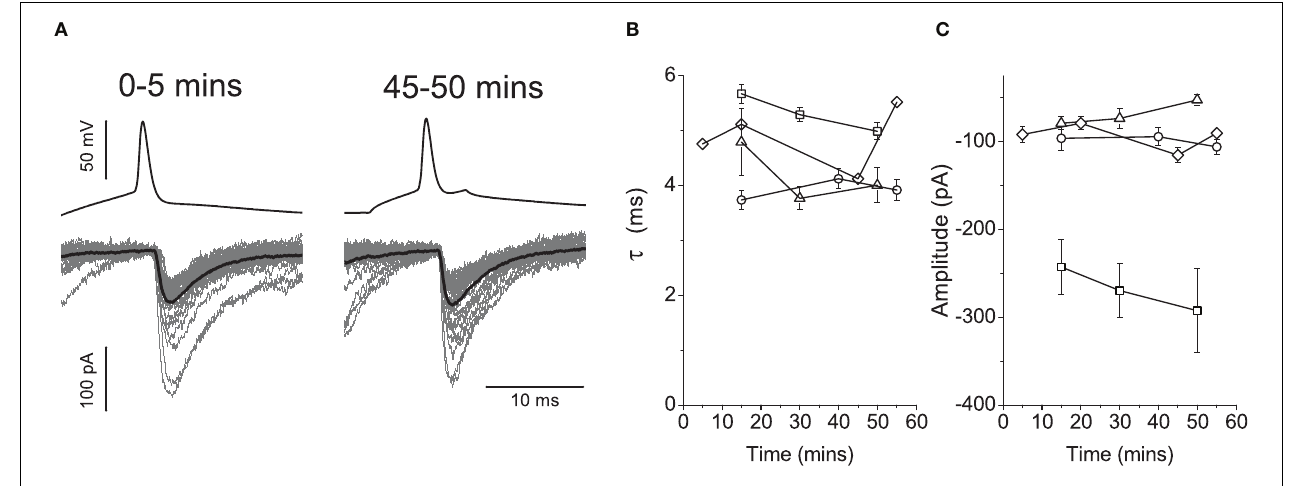
membrane of the pre-motor interneuron. Group data ( n = 4) is illustrated graphically to show changes in the decay constant (B) and amplitude (C) , neither of which showed systematic changes during the course of the loading glycine into the pre-synaptic